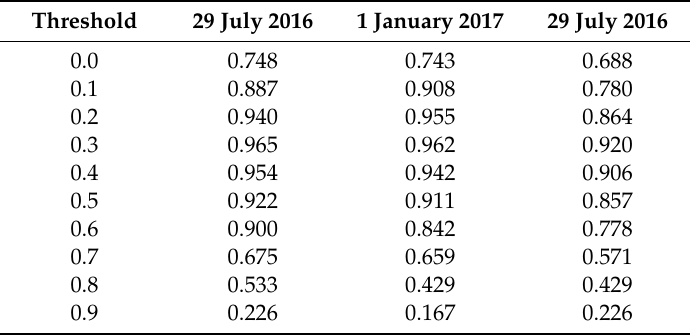
Table 5. F-measure by threshold for each observation date.